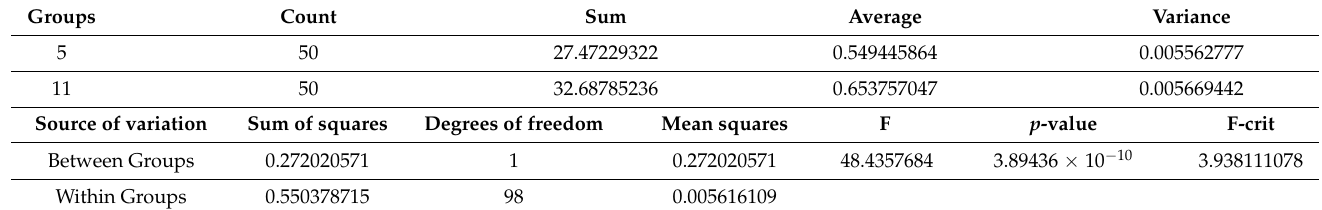
Table 7. ANOVA analysis of the model accuracy for models trained with 5 and 11 cultivation data for the fruiting